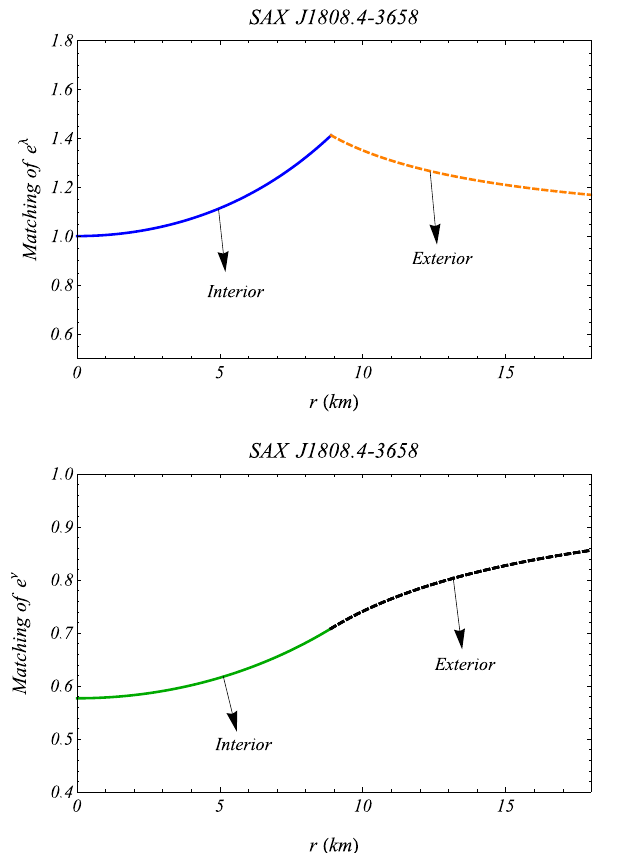
Fig. 1 The matching condition of the metric potential e λ and e ν are shown against the radius for the compact star SAX J 1808 . 4 −